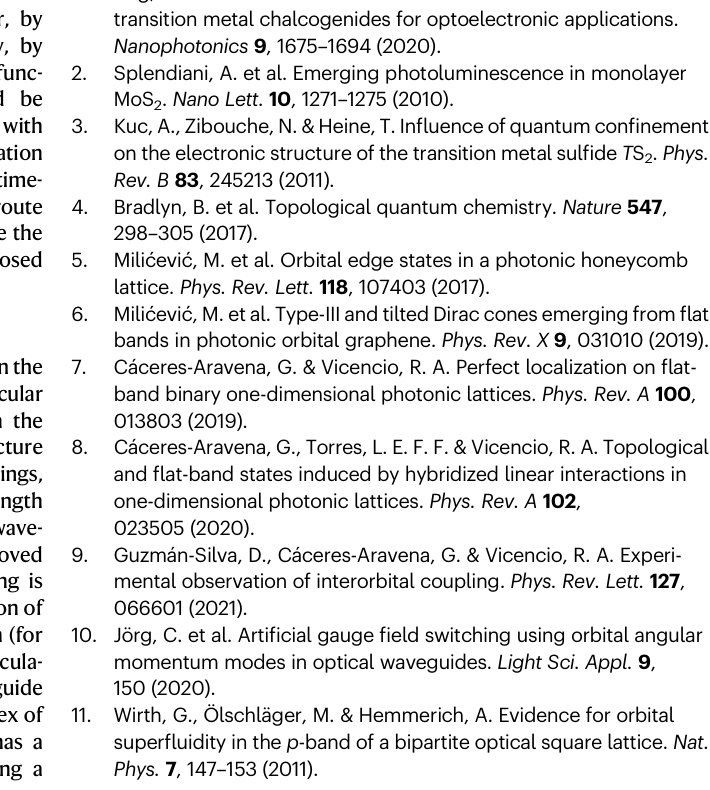
Fig. 4 | Direct excitation of the corner mode using an auxiliary waveguide weakly coupled to the system. a Cross-sectional image of the output facet of the waveguide array in the nontrivial phase with an auxiliary waveguide with a broad illumination of the input facet (see Supplementary Fig. S3). b Diffracted light measured at the output facet when light is injected into the auxiliary waveguide directlyattheleftcornerofthewaveguidearrayinthenontrivialphaseand c trivial phase, respectively. Waveguides, where light is injected at the input facet, are